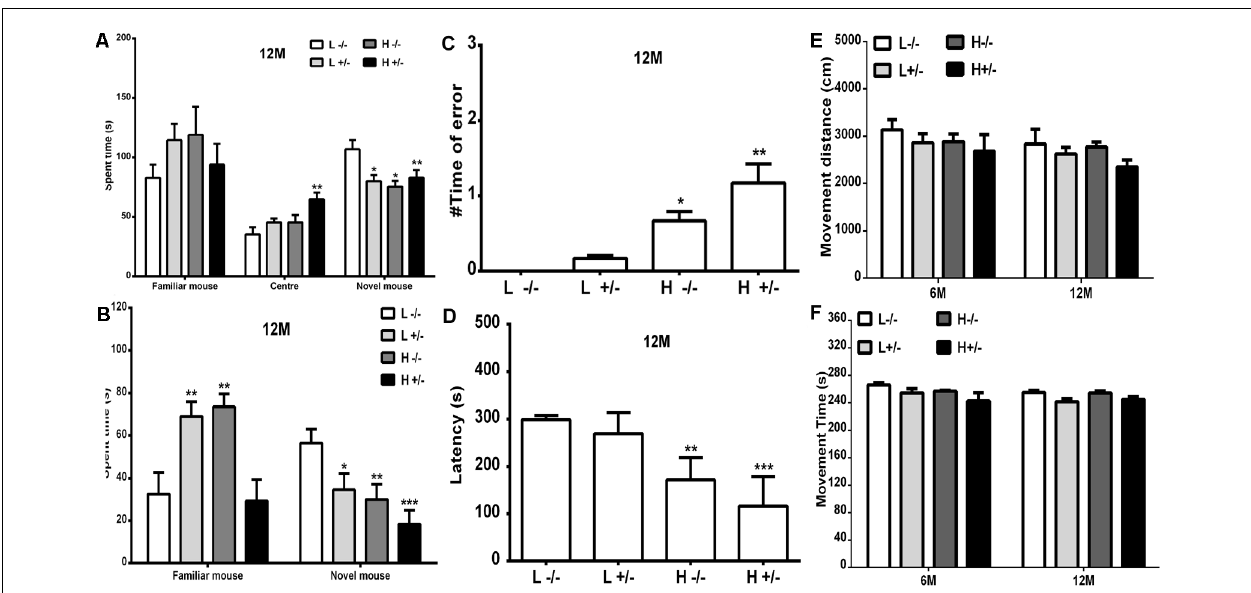
FIGURE 7 | Cognitive ability of hIAPP − / − and hIAPP + / − mice was impaired by a high-fat diet. (A,B) Social learning ability of hIAPP − / − and hIAPP + / − mice fed with a high/low-fat diet for 12 months was tested through the 3-chamber social test. (A) Time spent in different chambers was analyzed through the three-chamber social test (A) . (B) Time spent in social areas occupied by familial mouse and novel mouse was analyzed (B) . (C,D) Step-down test was used to evaluate the passive learning ability of hIAPP − / − and hIAPP + / − mice treated with a high/low-fat diet for 12 months. Times of error in step-down were analyzed (C) . Time spent on the safe platform was analyzed (D) . (E,F) Open-field test was performed to evaluate the movement function of hIAPP − / − and hIAPP + / − mice fed with a high/low-fat diet for 6 and 12 months. The movement distance (E) and movement time (F) were analyzed. L − / − denotes hIAPP − / − mice on a low-fat diet; L + / − denotes hIAPP + / − mice on a low-fat diet; H − / − denotes hIAPP − / − mice on a high-fat diet; H + / − denotes hIAPP + / − mice on a high-fat diet. n = 12, ∗ p < 0.05, ∗∗ p < 0.01, ∗∗∗ p < 0.001 compared with the L − / −